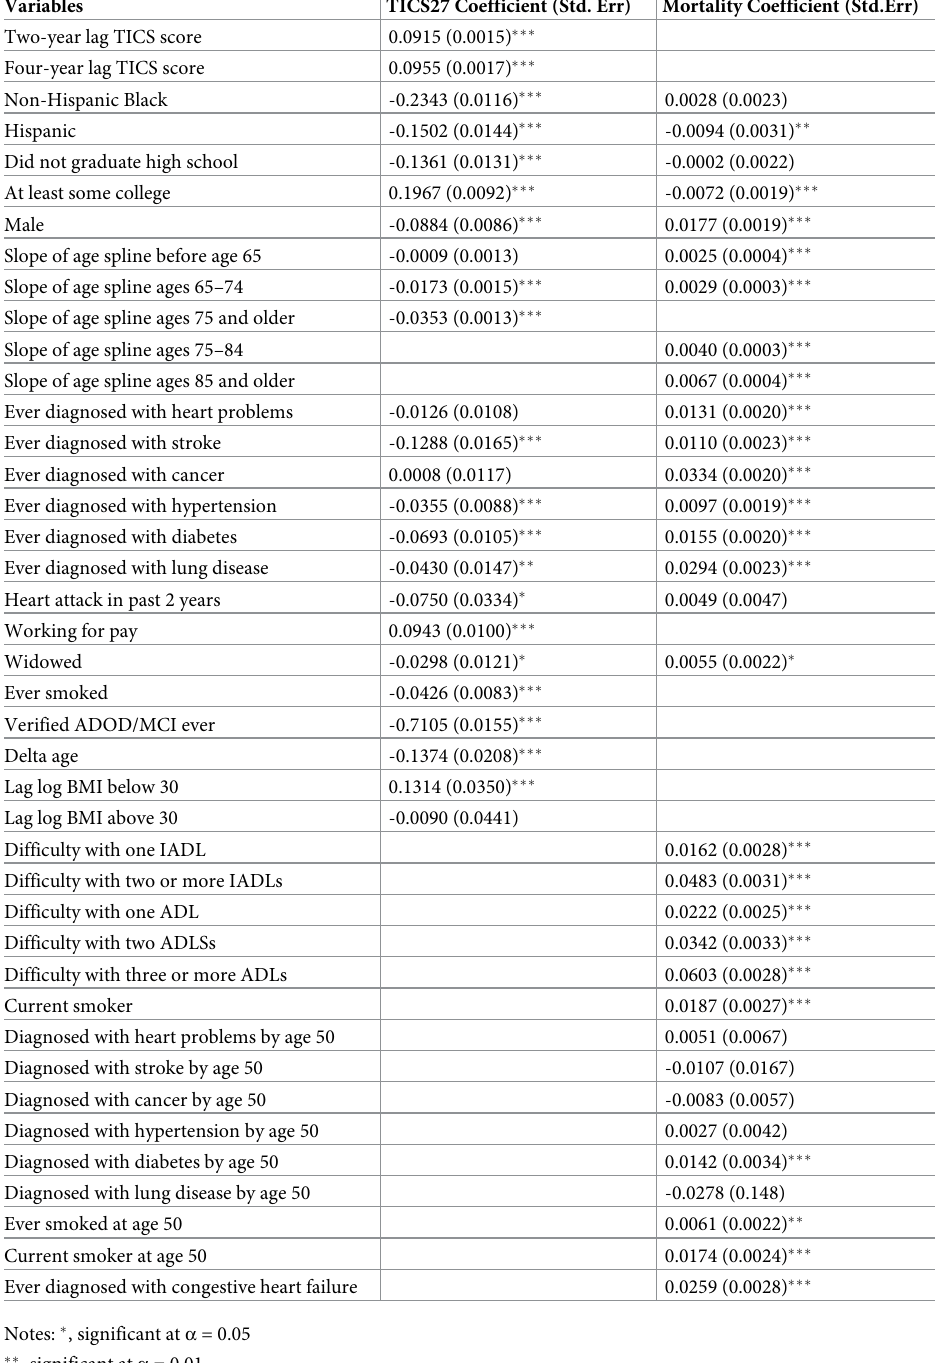
Table 1. Marginal effect from FEM TICS27 and mortality transition